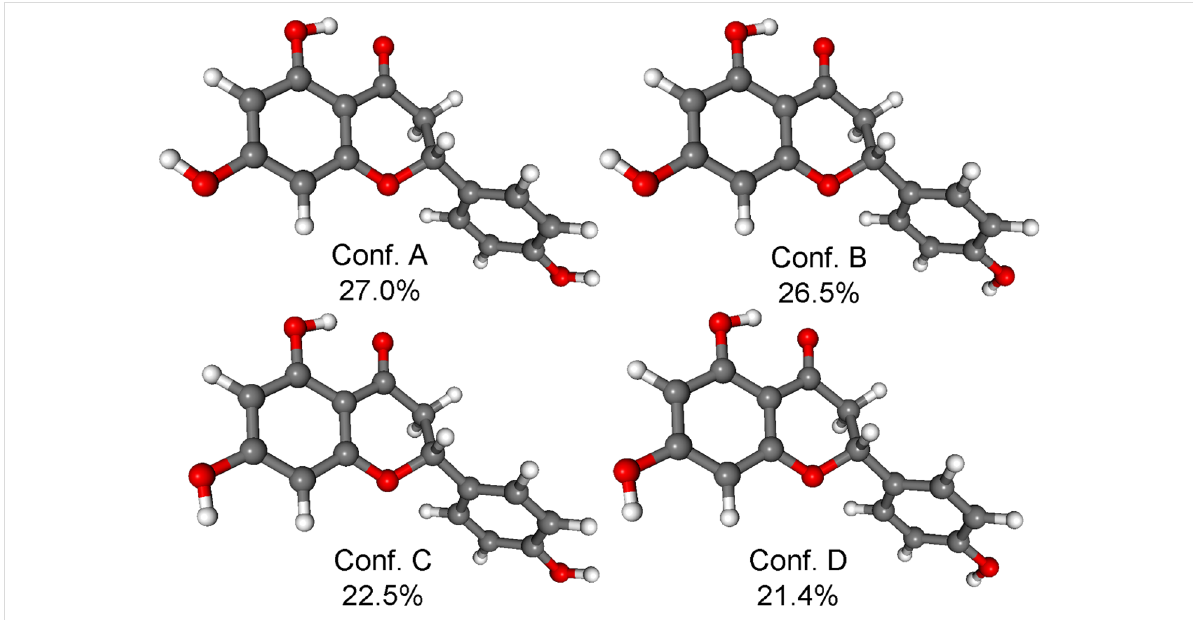
Figure 3: Structure and population of the low-energy CAM-B3LYP/TZVP PCM/CHCl 3 conformers (>2%) of ( R )- 1 .